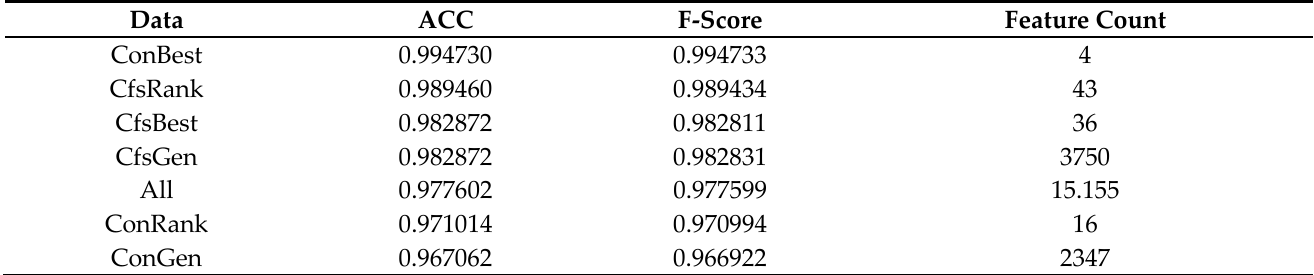
Table 11. The Average of Classification Results for each algorithm.